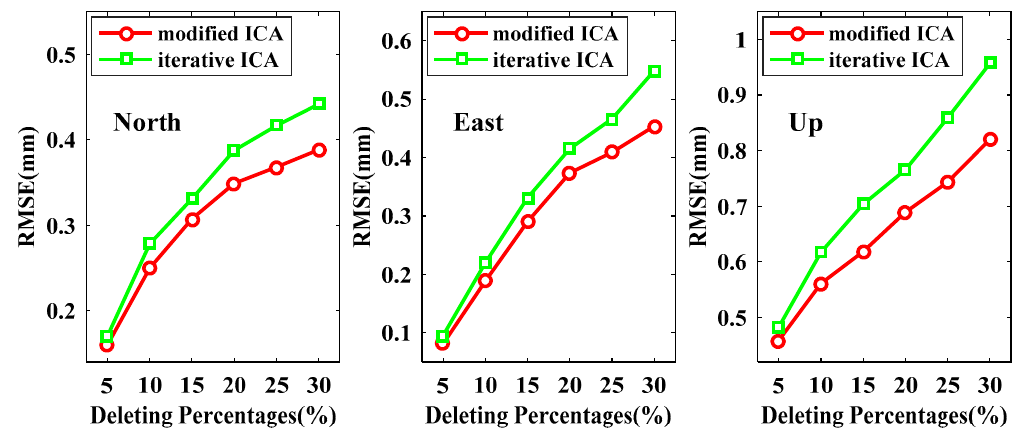
Figure 9. RMSEs of the reconstructed signals derived from modified ICA and iterative ICA at the non-deleting data points.